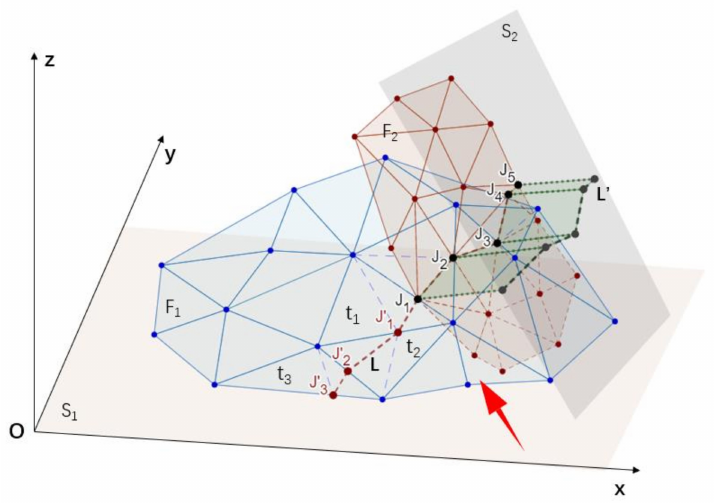
Figure 8. Schematic diagram of the extension of the intersection line of the fault